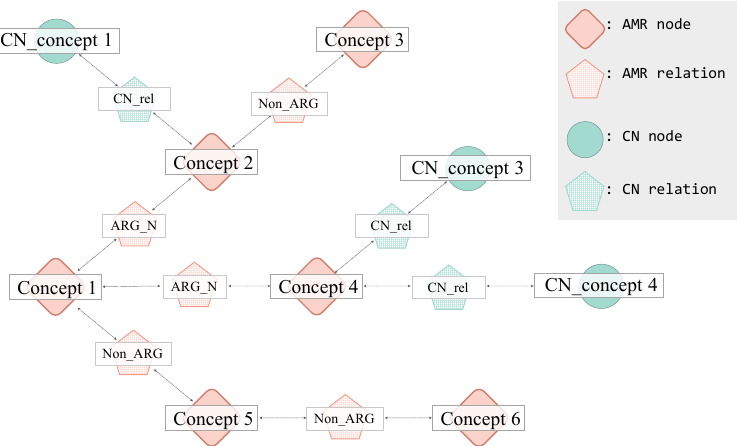
Figure 2. Example of an ACP -ARG